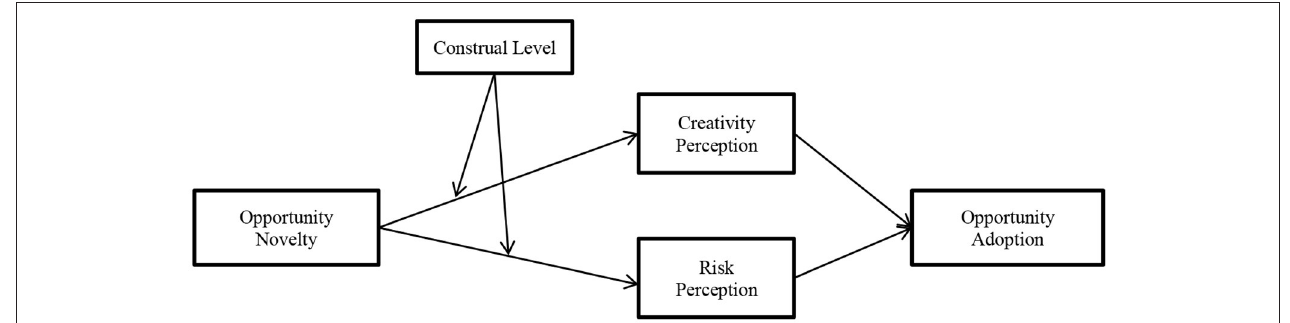
FIGURE 1 | The conceptual